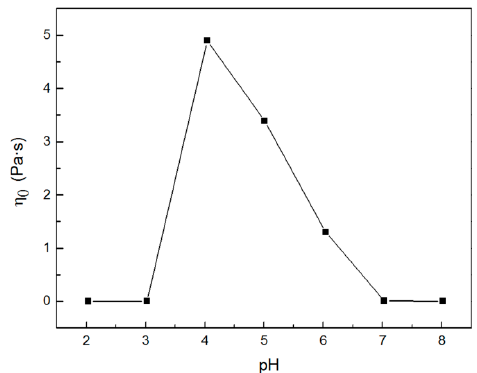
Figure 2. Variations of zero-shear viscosity ( η 0 ) as a function of 80 mM C 16 MPBr-AA aqueous solution with different pH values.